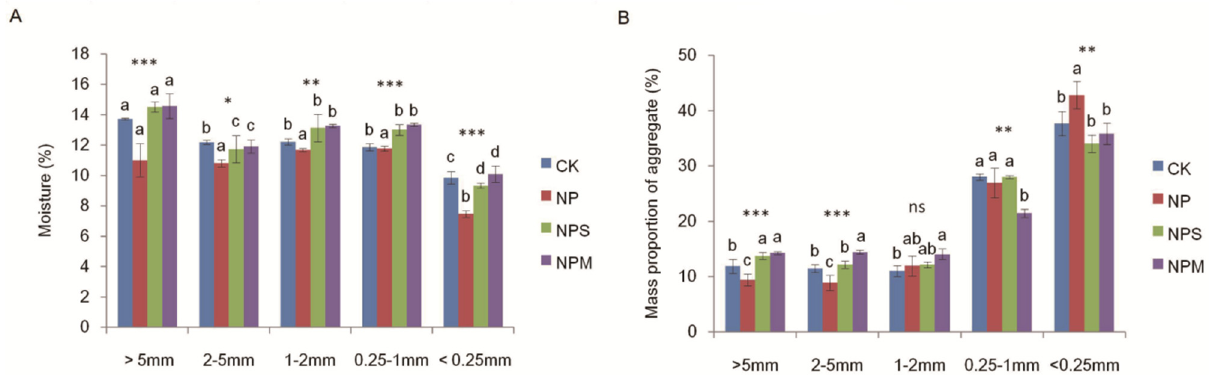
Figure 3. The moisture ( A ) and mass proportion ( B ) of different aggregates under 4 fertilization managements (CK, NP, NPS, and NPM). Different lowercase letters mean significant differences among aggregate size fractions ( p < 0.05). The differences in moisture and mass proportion among fertilization managements are shown at *: p < 0.05, **: p < 0.01, ***: p < 0.001, and ns: not significant.